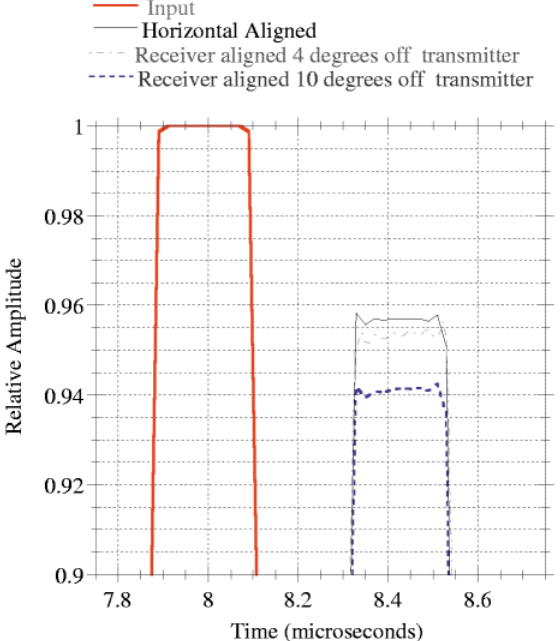
FIG. 25. (Color) The effect of rotating one of the mode TE 12 mode transducers with respect to the other.